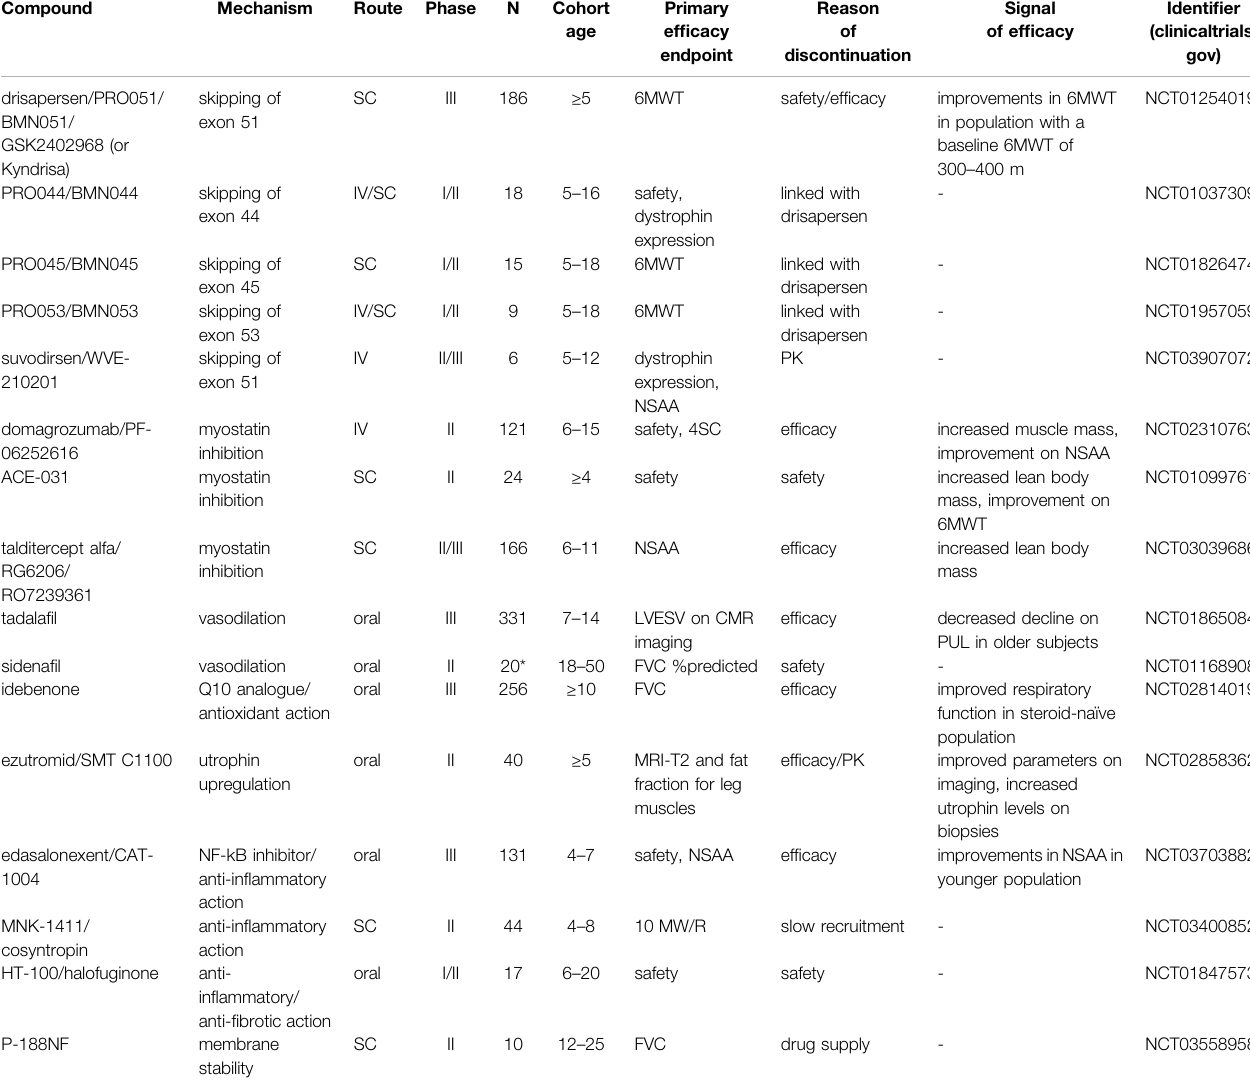
TABLE 1 | Compounds discontinued during clinical development for DMD.